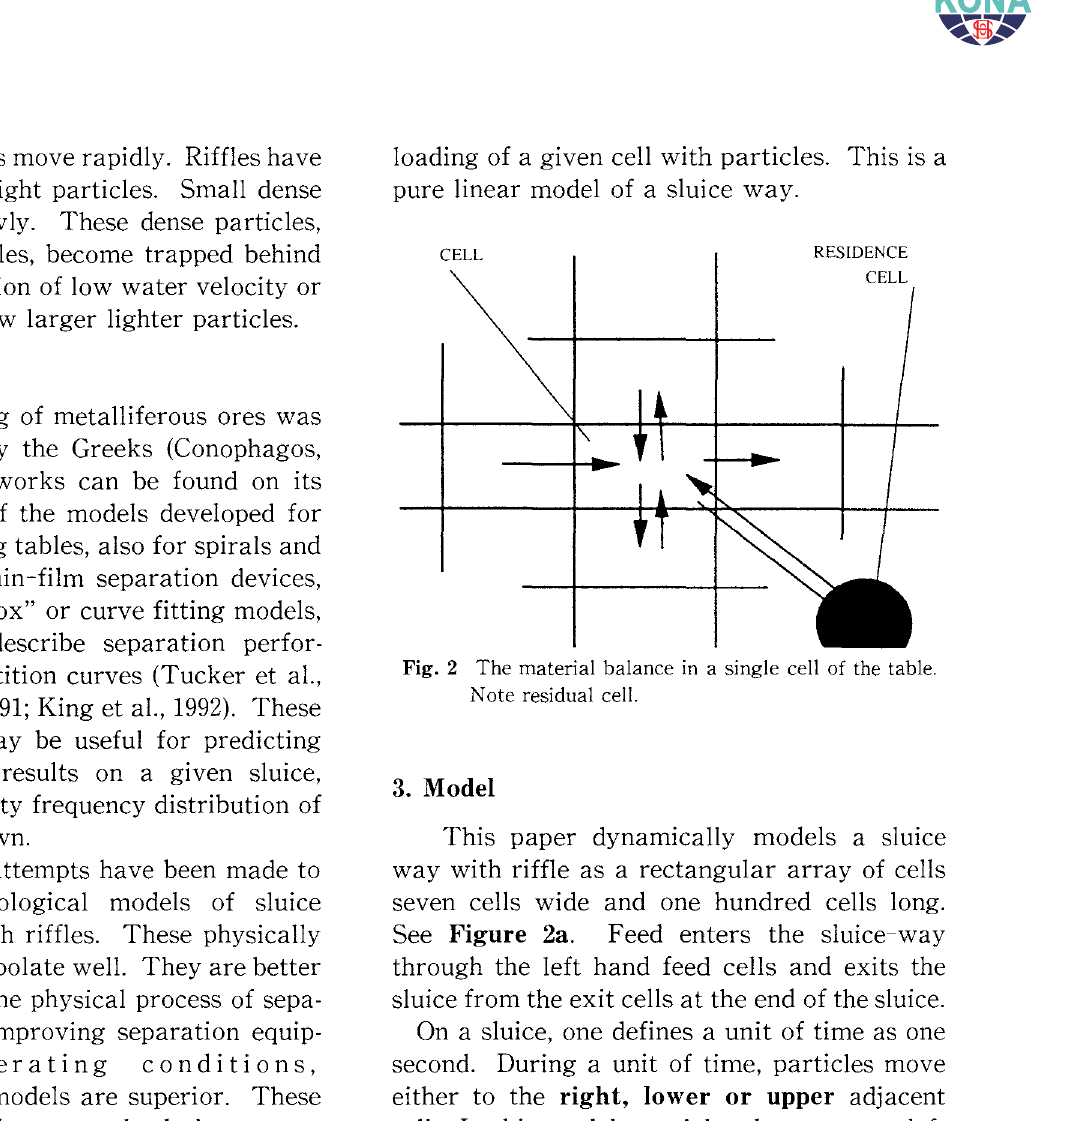
Fig. 2 The material balance in a single cell of the table. Note residual